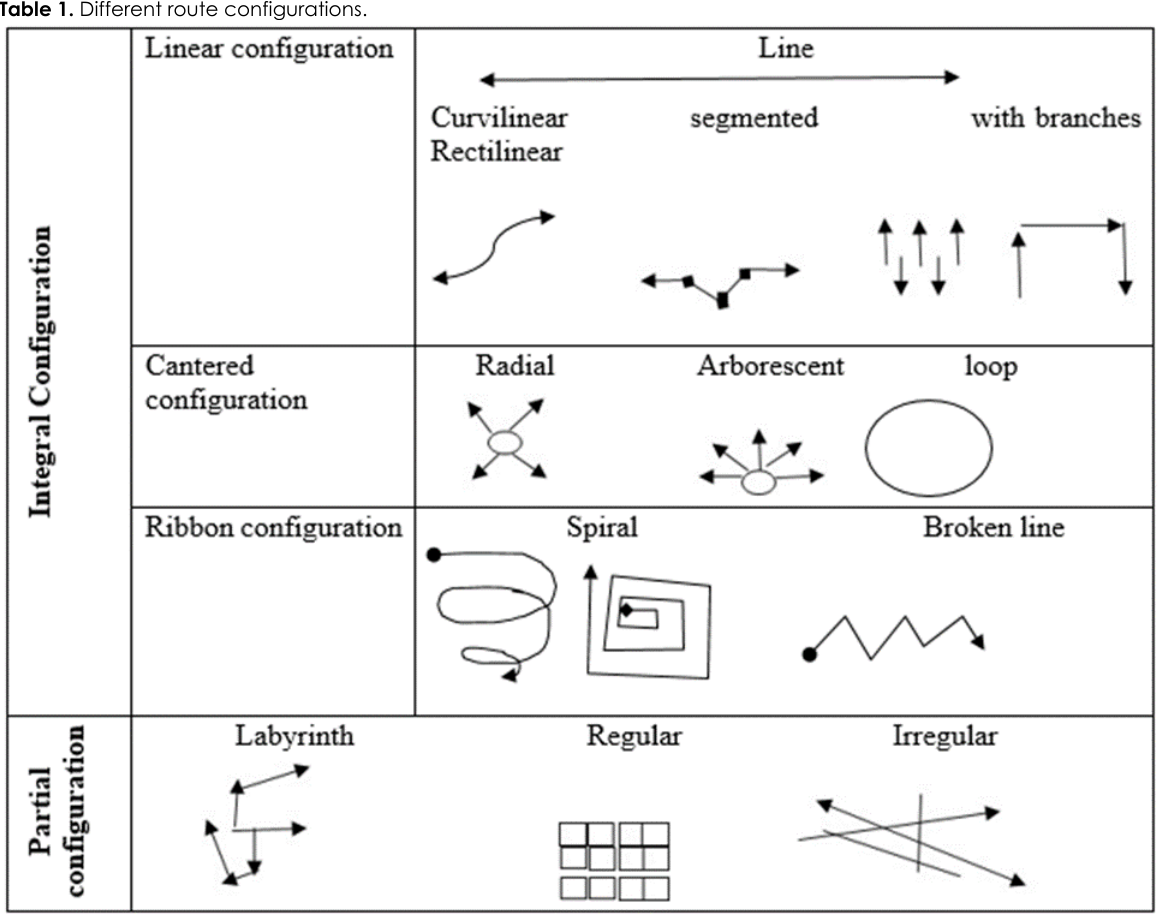
Table 1. Different route